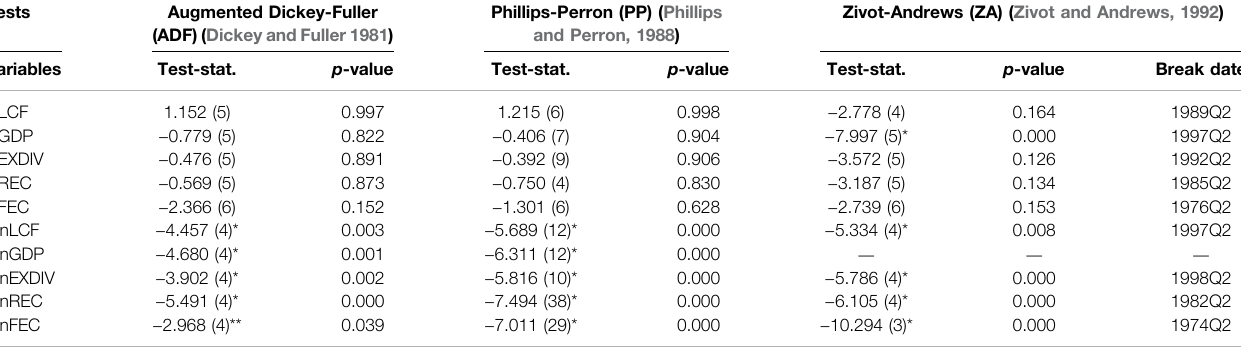
TABLE 2 | Results of unit root tests.